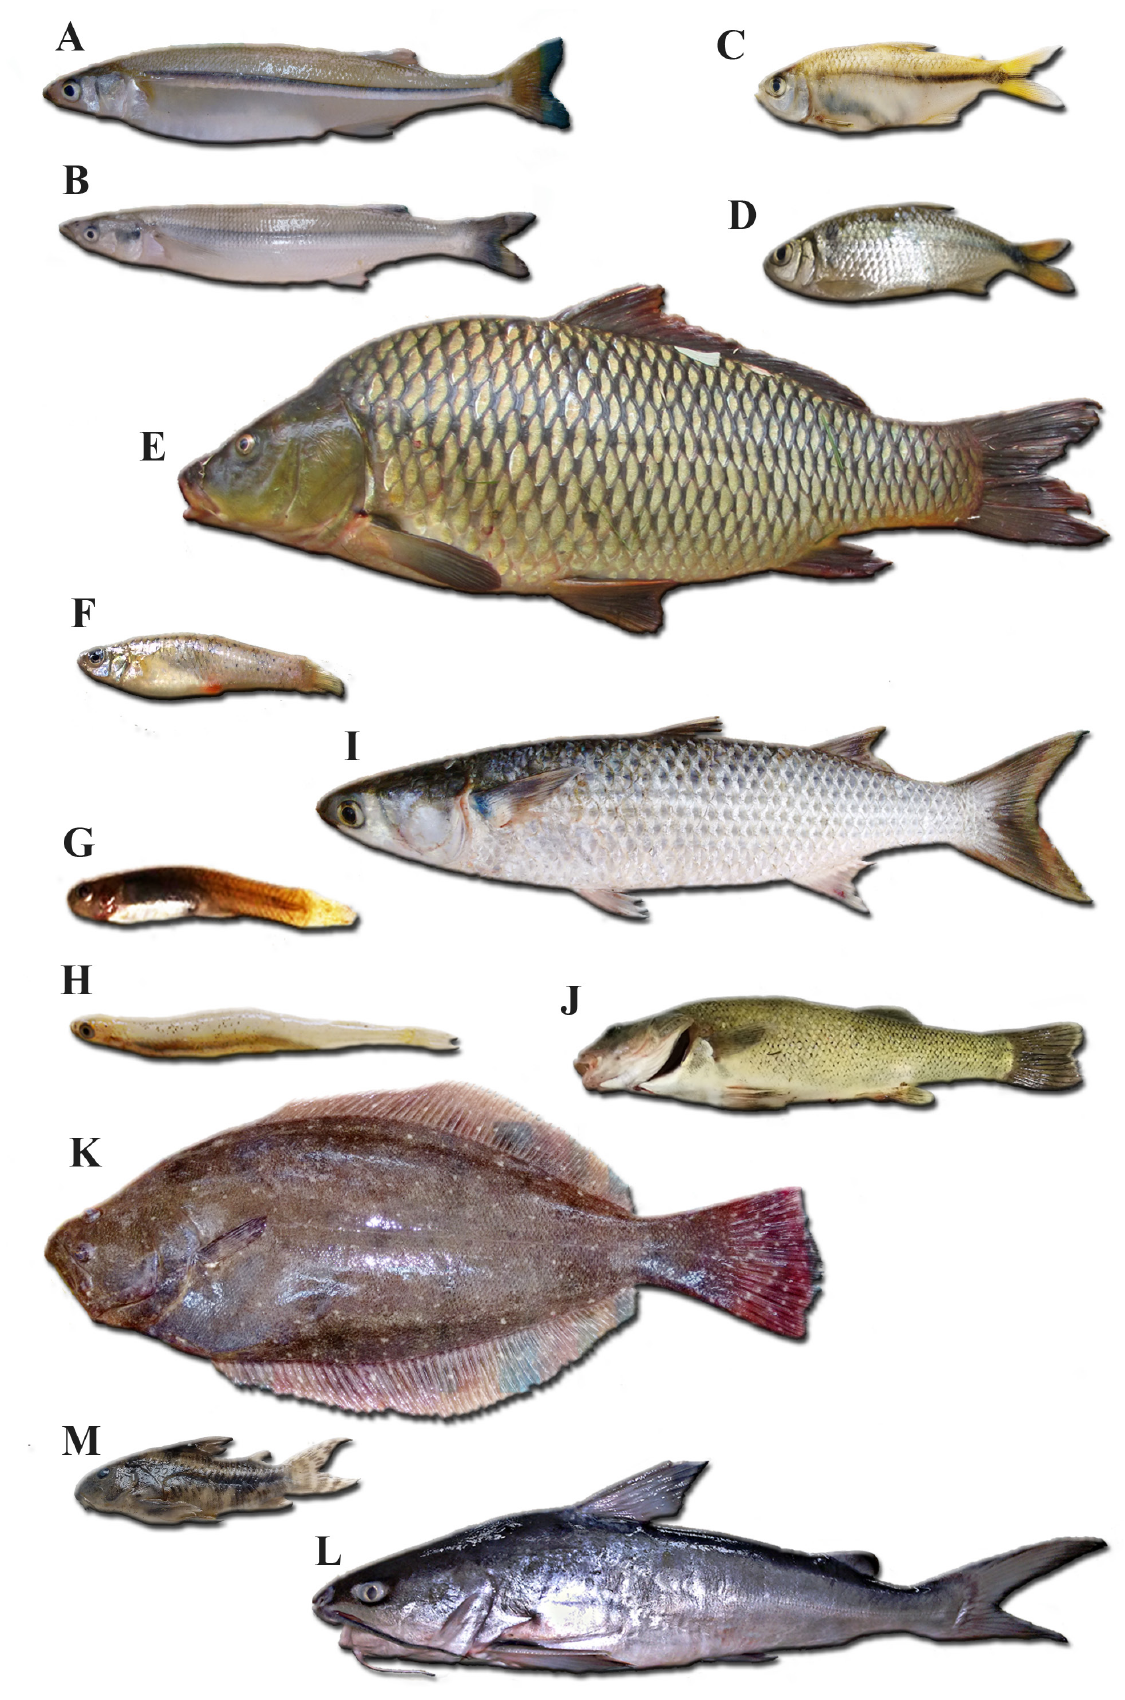
Figure 3. Fishes of the lower course of the Negro river drainage. A. Odontesthes bonariensis, MPCN-Ict 1, 110 mm TL. B. O. hatcheri , MPCN- Ict 2, 98 mm TL. C. Cheirodon interruptus , MPCN-Ict 3, 64 mm TL. D. Psalidodon pampa , MPCN-Ict 4, 73 mm TL. E. Cyprinus carpio , MPCN-Ict 5, 418 mm TL. F. Jenynsia lineata , MPCN-Ict 6, 59 mm TL. G. Cnesterodon decemmaculatus, MPCN-Ict 7, 36 mm TL. H. Galaxias maculatus , MPCN-Ict 9, 57 mm TL. I . Mugil liza , MPCN-Ict 8, 501 mm TL. J. Percichthys trucha , MPCN-Ict 10, 272 mm TL. K. Paralichthys brasiliensis , MPCN-Ict 11, 385 mm TL. L. Genidens barbus , MPCN-Ict 13, 320 mm TL. M. Corydoras paleatus , MPCN-Ict 12, 75 mm